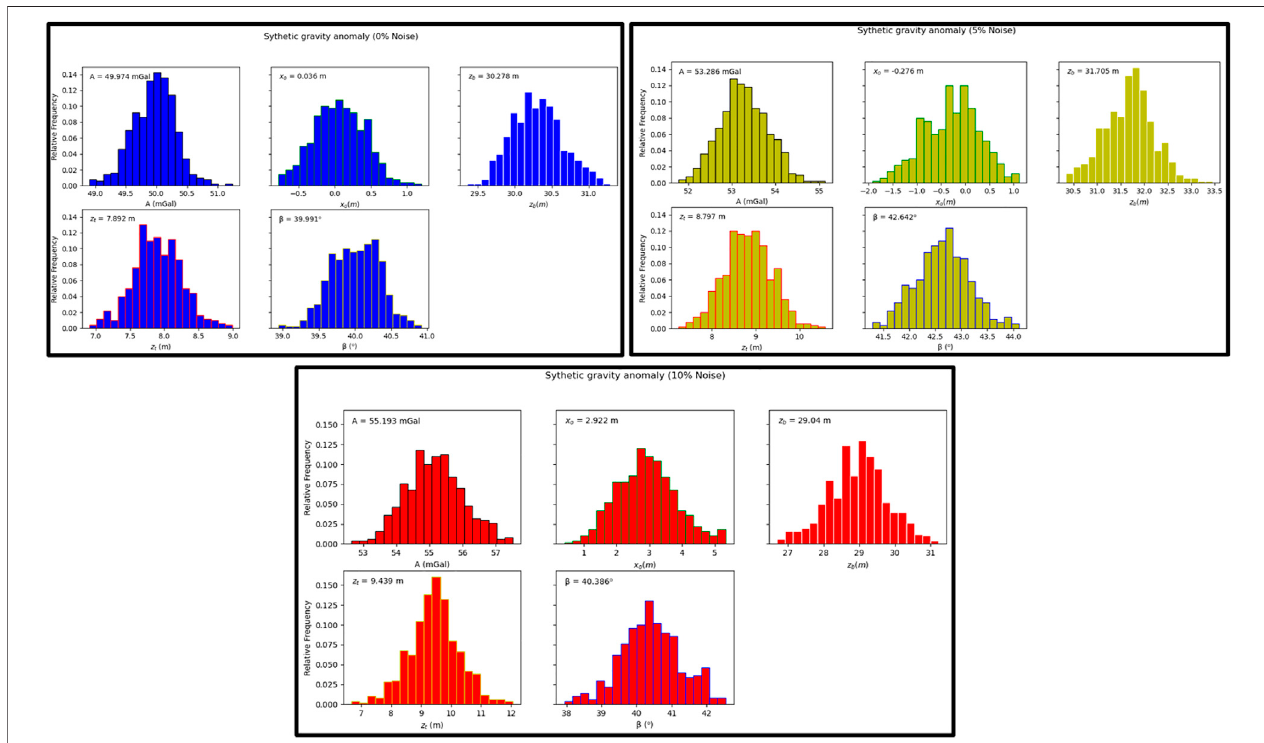
FIGURE 7 | Produced histograms after uncertainty appraisal using MCMC algorithm (synthetic gravity anomaly). Estimated values indicated on upper-left part of the chart.